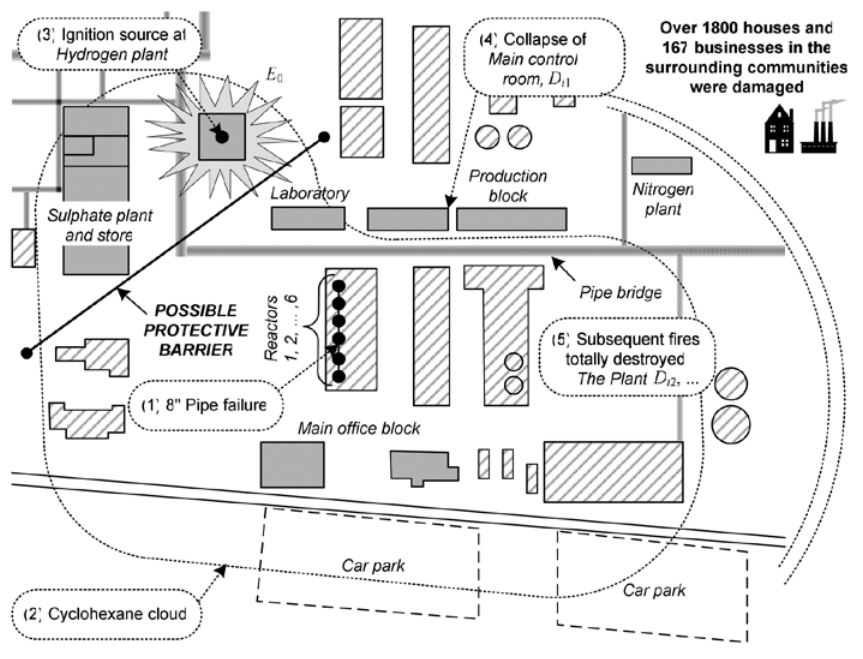
fig. 5. Simplified accident scenario at Nypro Works, Flixborough, 1974 (Høiset et al. 2000) and possible separation of ignition source (hydrogen plant) at Nypro factory using protective